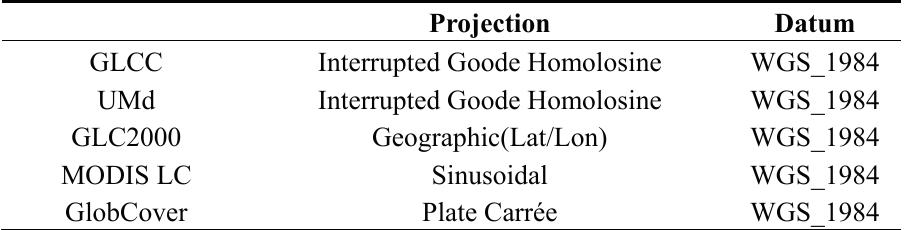
Table 2. Original projections of the compared land cover data